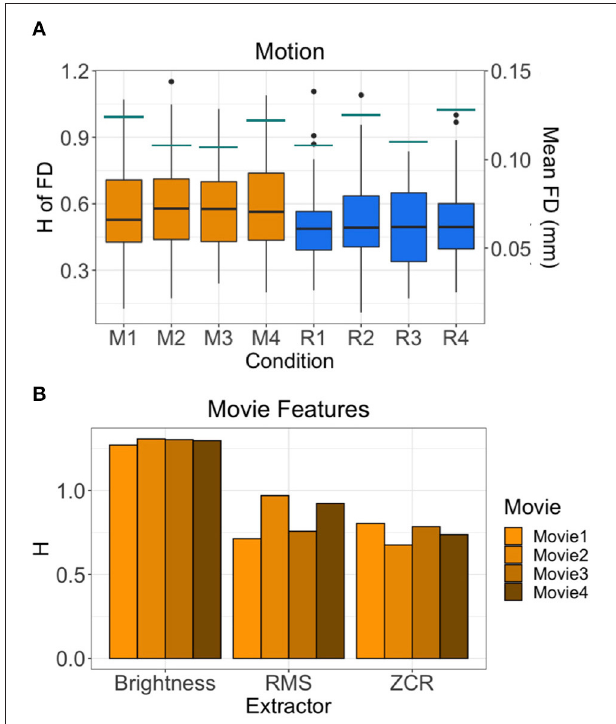
FIGURE 5 | H values of other possible sources of fractality. (A) H values of the FD time-series of all 72 subjects by run are shown in the boxplots. Orange boxplots are the Movie runs (M1 = Movie1, M2 = Movie2, M3 = Movie3, M4 = Movie4), blue are the Rest runs (R1 = Rest1, R2 = Rest2, R3 = Rest3, R4 = Rest4). The mean FD values are shown by the horizontal teal lines for each run using the secondary y-axis (right). (B) H values of the time-series of three movie features (brightness, RMS, ZCR) for each